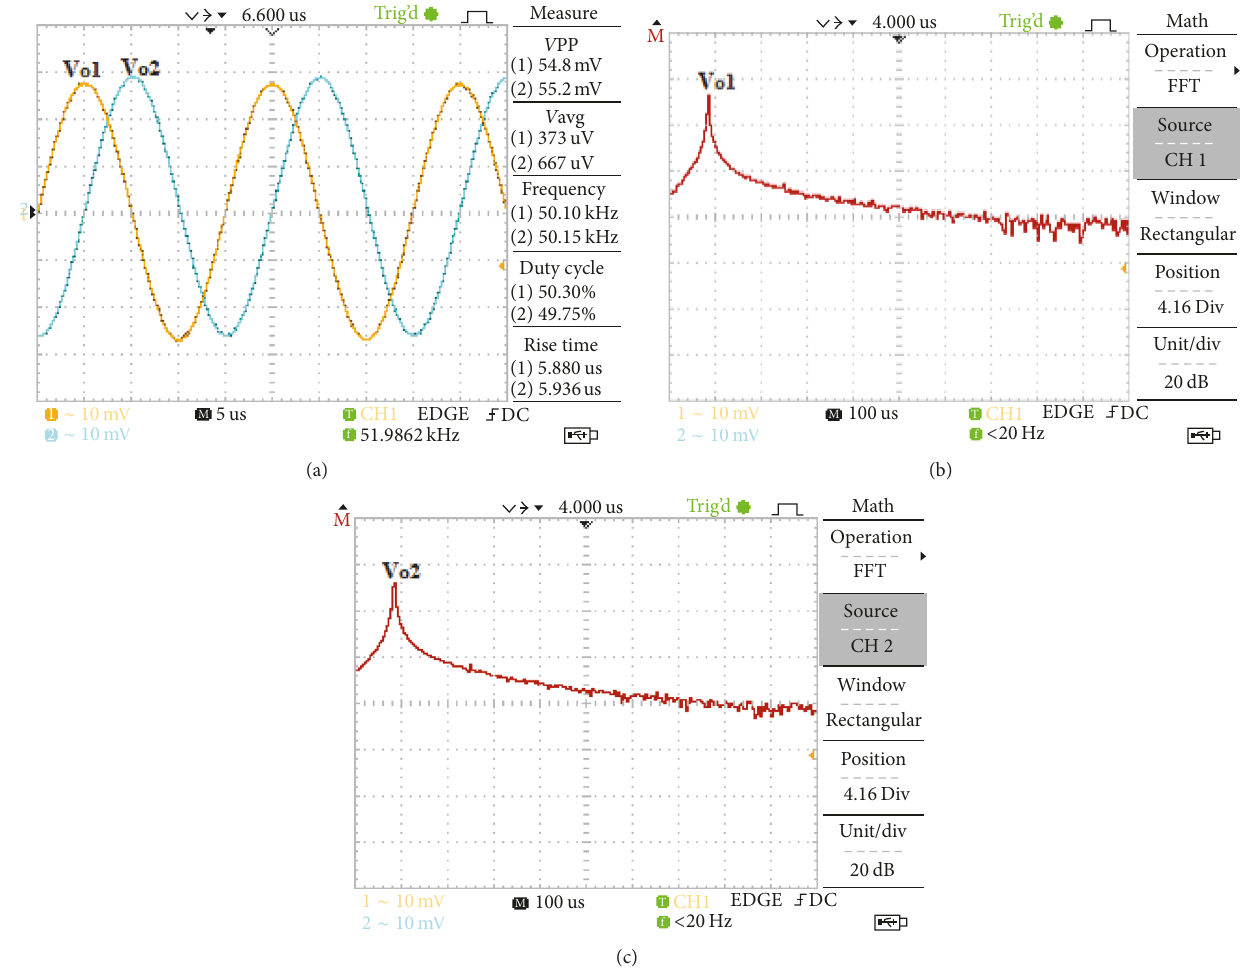
Figure 5: Measurement of output voltages and their spectrums at 𝑓 0 = 50 kHz.